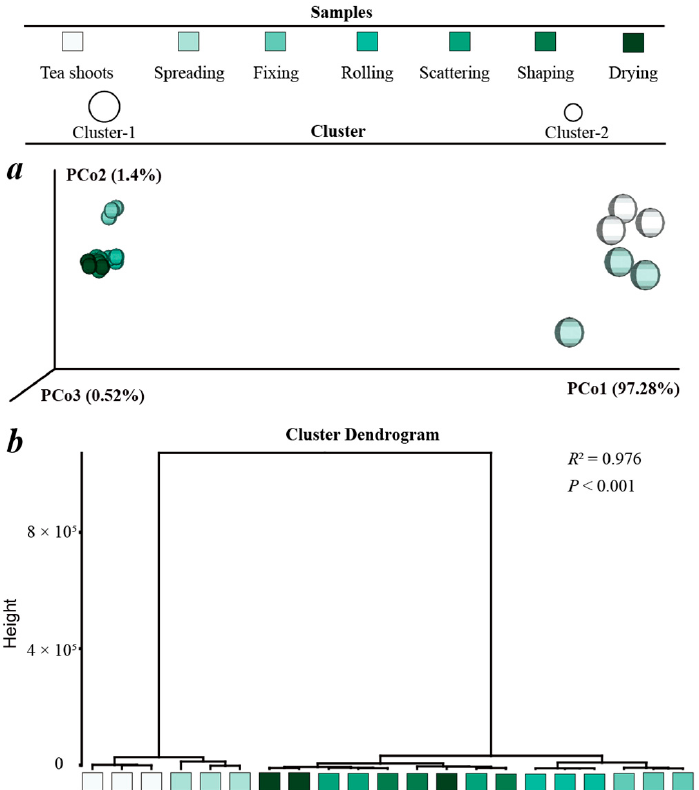
Figure 7. Principal coordinate analysis ( a ) and hierarchical clustering analysis ( b ) of the processed XYMJ green tea samples. The β diversities of volatile compounds were based on Manhattan dissimilarities. ( a ): PCoA scatter plots of the volatile compounds in the processed XYMJ green tea samples, ( b ): the dendrograms represent HCA. PERMANOVA R 2 and p values were indicated for the two clusters of the volatile compounds, which were represented by circles of different sizes.